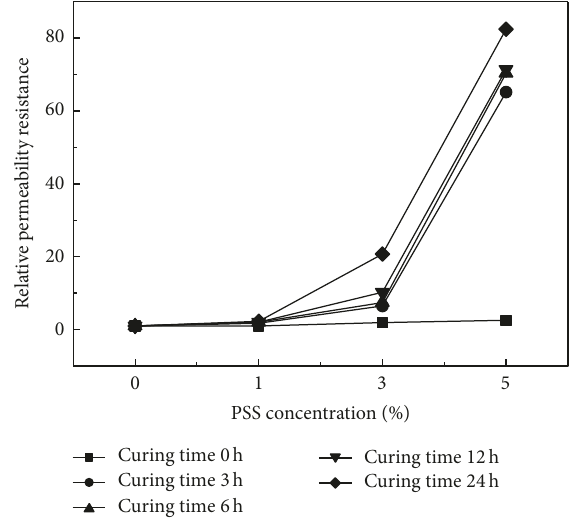
Figure 10: The relative permeability resistance (𝑅) of specimens with PSS concentrations of 1%, 3%, and 5% at different curing times.